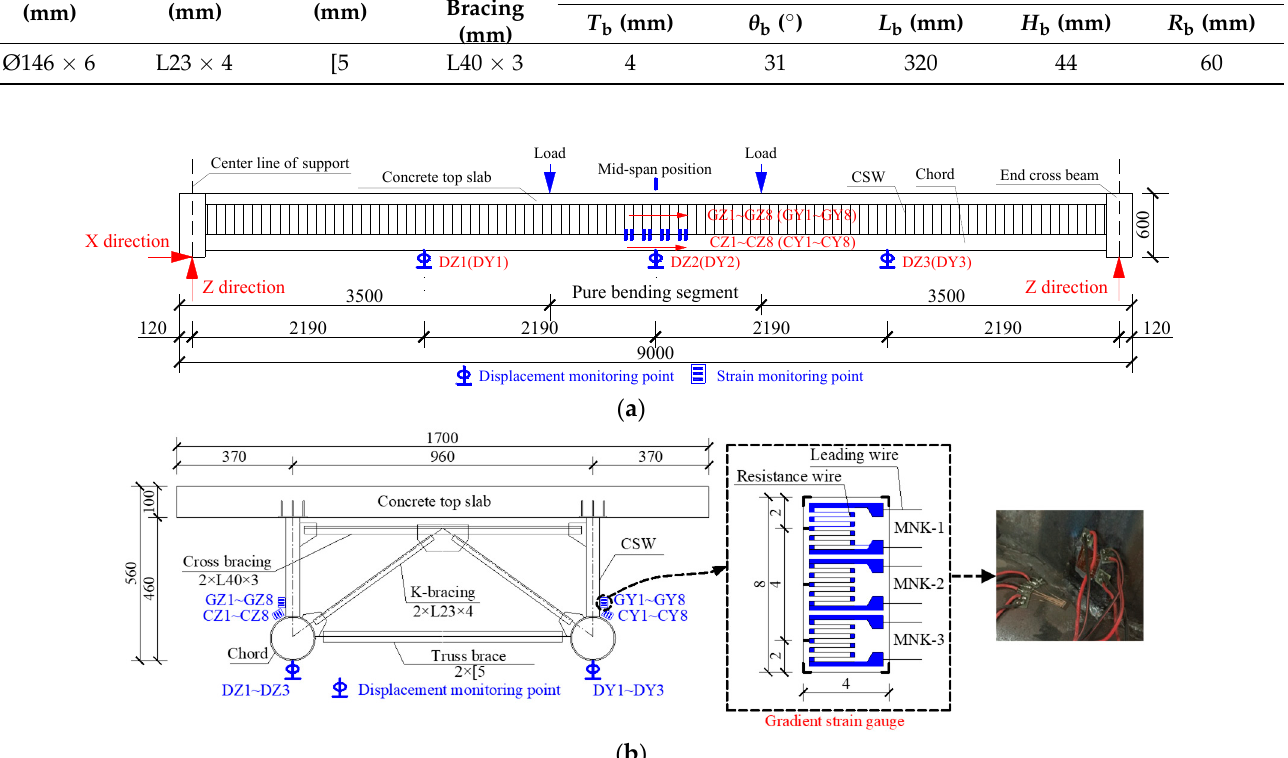
Figure 3. Test model (unit: mm): ( a ) vertical plan; and ( b ) sectional plan.